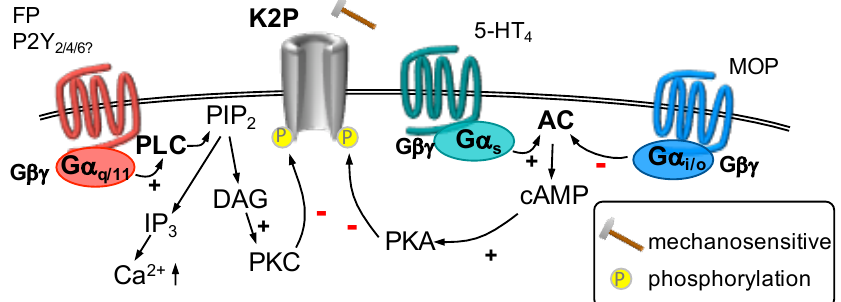
Figure 3. K 2 P channels are opened in response to mechanical stimuli. Stimulation of a G α q /11 -coupled receptor ( left ) activates phospholipase C (PLC). Hydrolyzation of phosphatitylinositol 1,4, bisphosphate (PIP 2 ) forms inositiol 1,4,5 trisphosphate (IP 3 ) and diacylglycerol (DAG). DAG activates protein kinase C (PKC) which phosphorylates K 2 P channels decreasing their function. Activation of G α s -coupled receptors ( center ) leads to activation of adenylyl cyclase (AC) which produces cyclic adenosine monophosphate (cAMP). Thereafter, protein kinase A (PKA) is activated which phosphorylates K 2 P channels and decreases their currents. Stimulation of G α i / o -coupled receptors ( right ) decreases AC activity. Therefore, less cAMP is formed, PKA is less active and subsequently K 2 P channels are not phosphorylated, which increases their